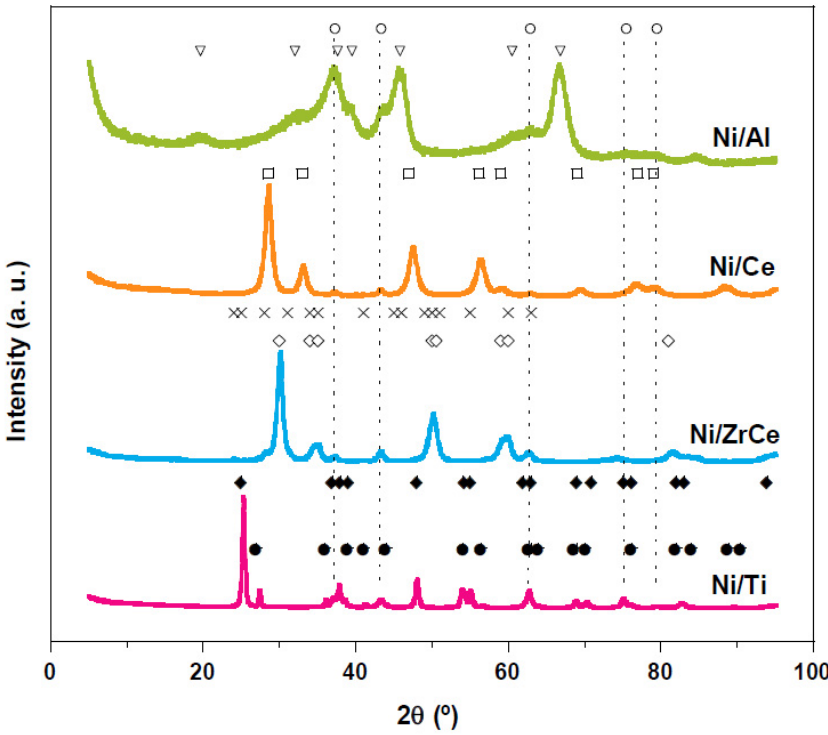
Figure 1. XRD patterns of the calcined supported Ni catalysts. Crystalline phases identified: ( ○ ) NiO, ( ▽ ) γ -Al2O3, ( □ ) CeO2, ( ◇ ) (Zr0.88Ce0.12)O2, (×) ZrO2 baddeleyite, ( ◆ ) TiO2 anatase, and ( ● ) TiO2 rutile.